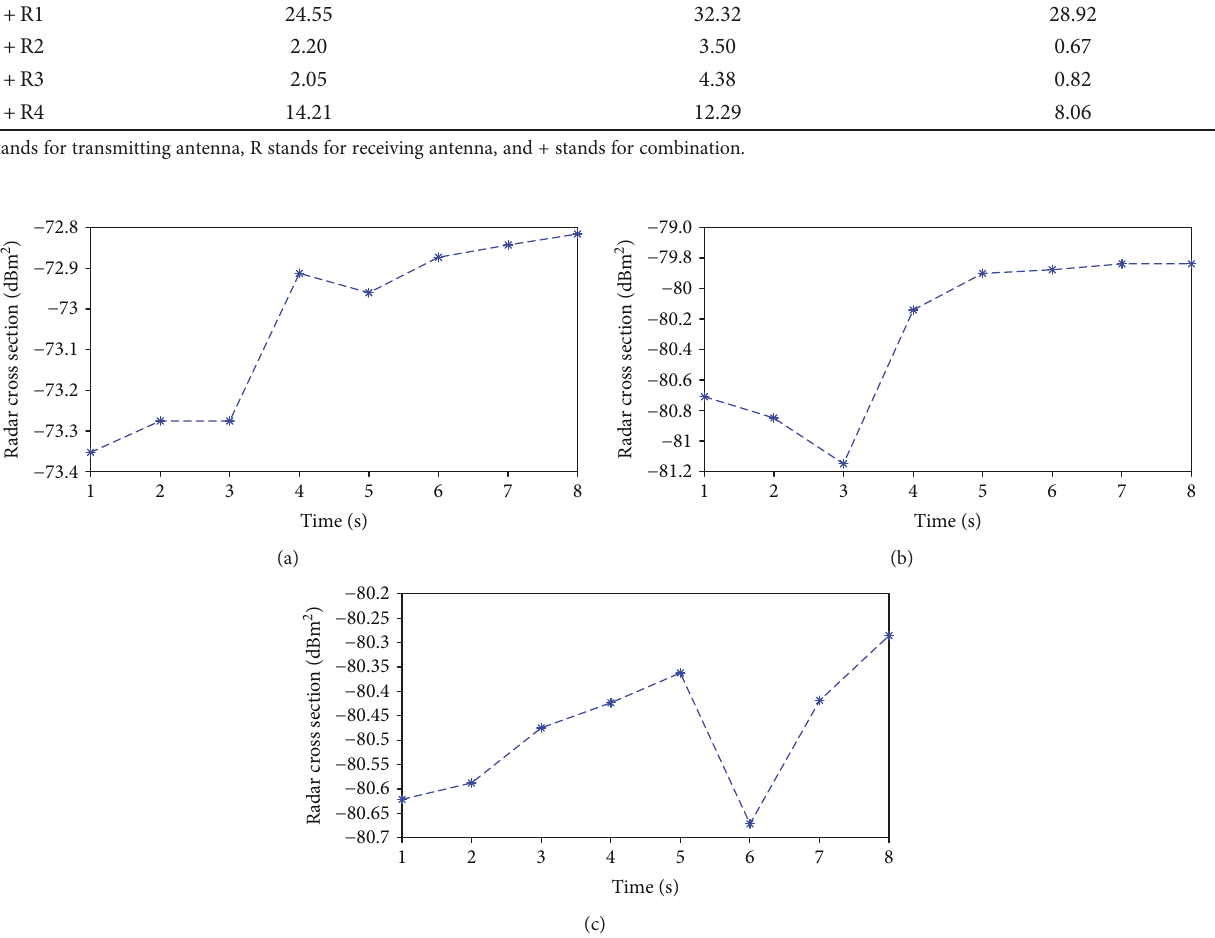
Figure 7: Coherent cumulative averaging results of (a) horizontally rotated hexagonal column particles, (b) horizontally rotated ellipsoidal particles, and (c) horizontally rotated spherical particles by means of